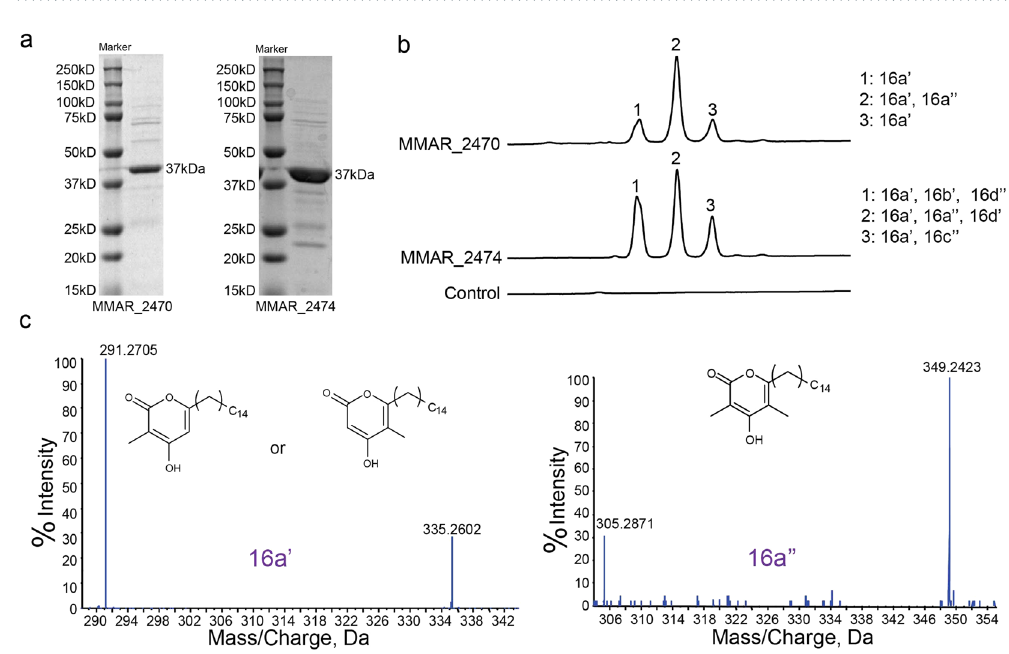
Figure 3. Biochemical analyses of MMAR_2470 and MMAR_2474 proteins and mass spectrometric characterization of reaction products. ( a ) SDS-PAGE profiles of purified MMAR_2470 and MMAR_2474 proteins. ( b ) UFLC chromatograms at 280 nm for reaction products of enzymatic assays carried out independently for both the Mmar type III PKS proteins. Reactions were primed with palmitoyl-CoA (C 16 -CoA) as starter substrate and both malonyl- and methymalonyl-CoA as extender substrates. Control chromatogram represents reaction carried out in the absence of Mmar proteins. ( c ) Tandem MS/MS analysis of reaction products of MMAR_2470